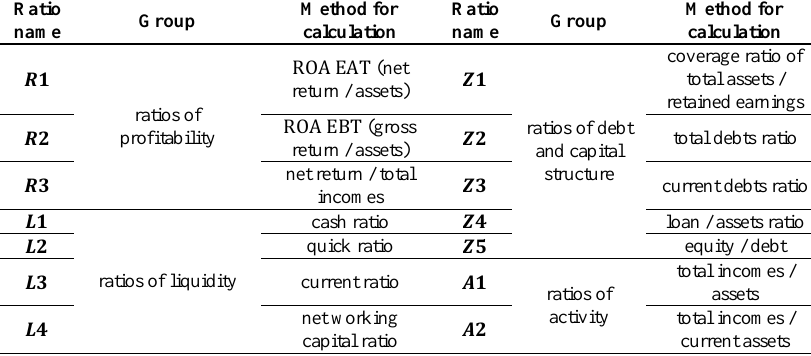
Table 2. Cross-table of variables “being an outlying company” and “being a non-